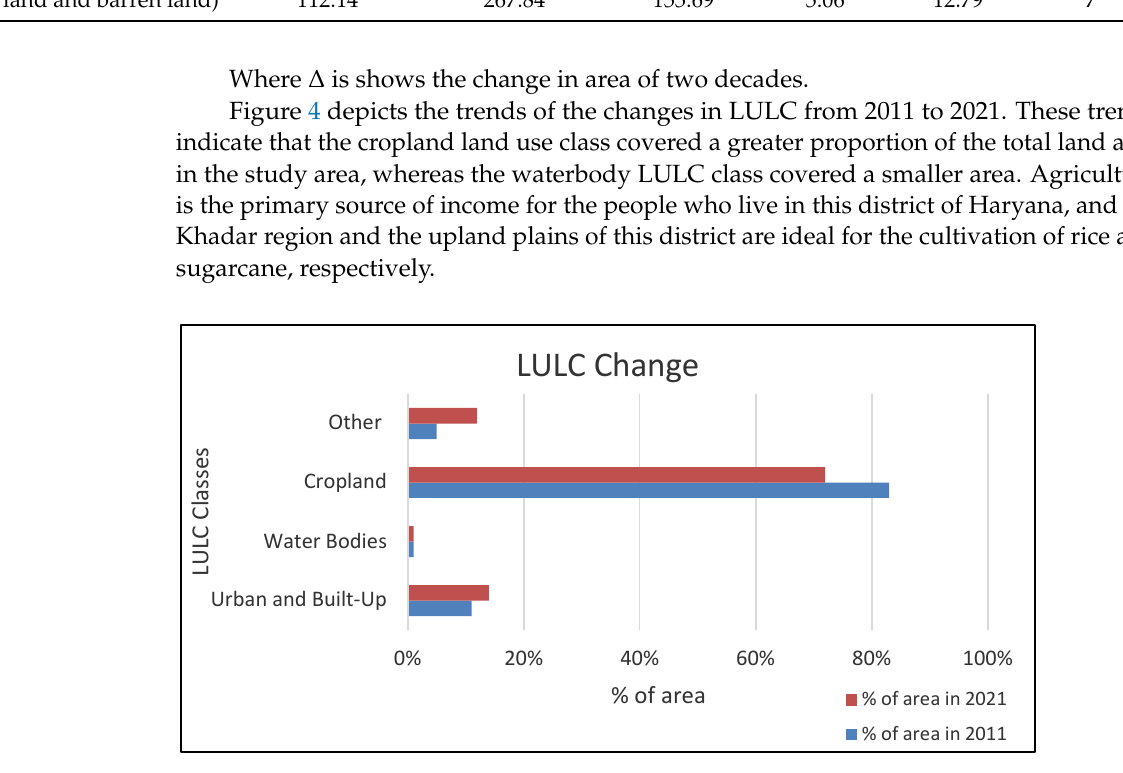
Figure 4. LULC change trends for 2011 and 2021.